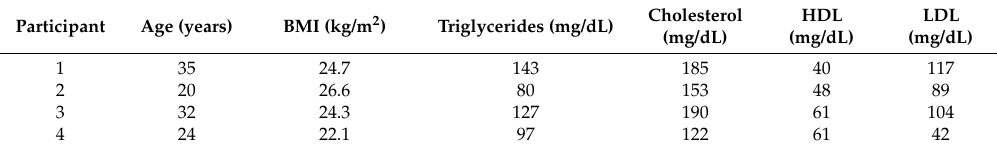
Table 1. Individual characteristics and blood laboratory parameters of study